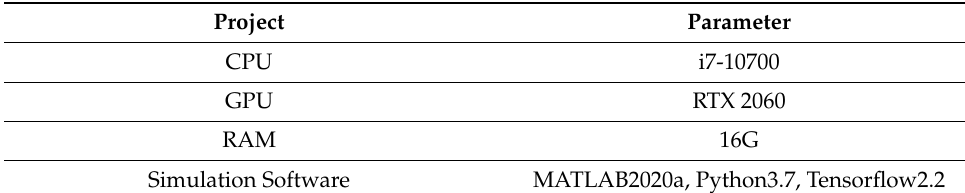
Table 1. Experiment platform parameters.